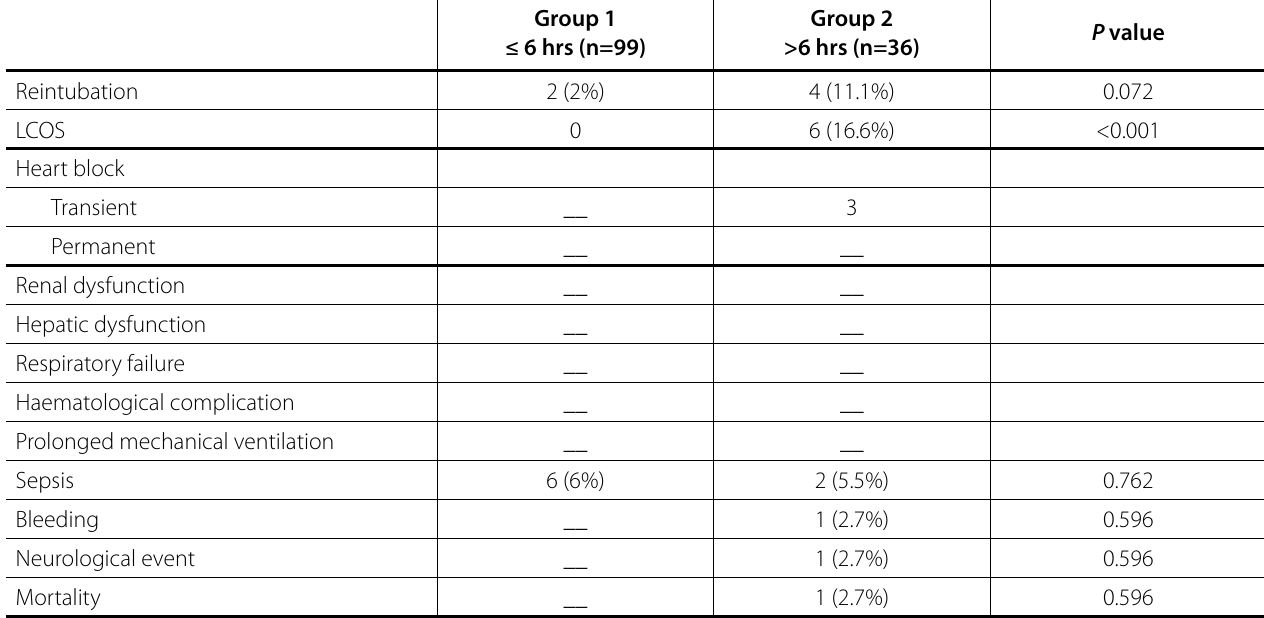
Table 3. Postoperative complications and